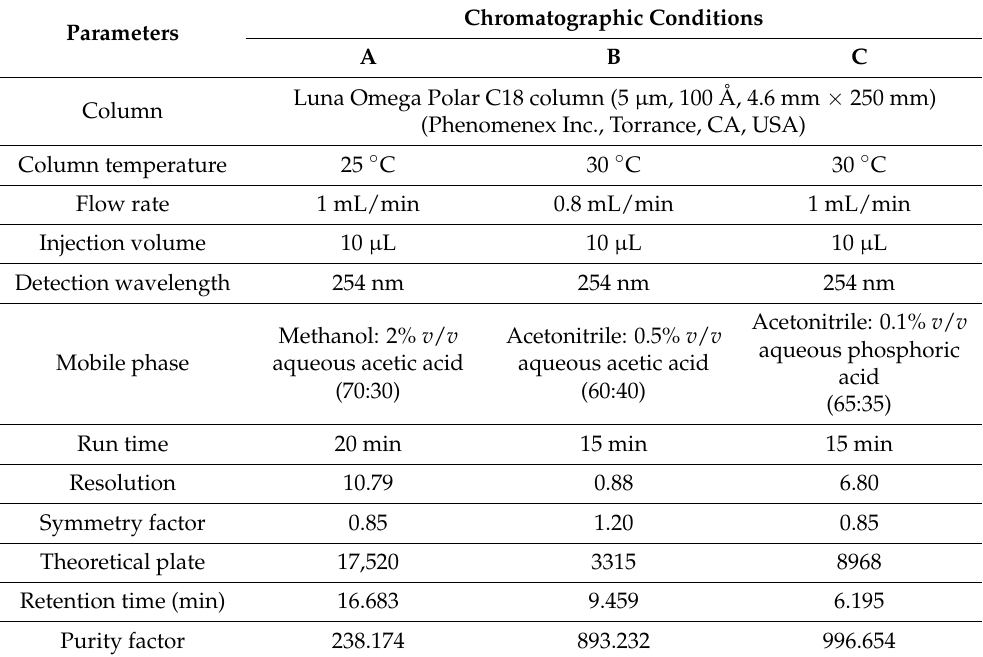
Table 4. Analytical conditions of the HPLC system for determining